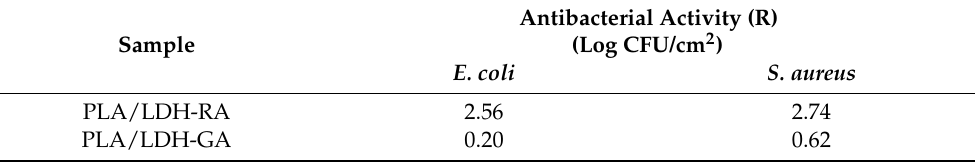
Table 3. Antibacterial activity (R) of PLA/LDH-RA and PLA/LDH-GA against E. coli and S. aureus